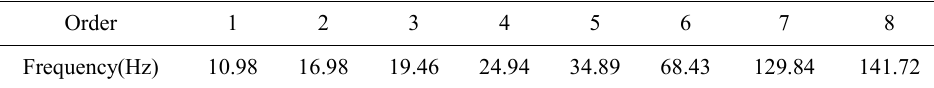
Table 2. Torsional vibration frequency of six-cylinder six-exhaust steam shafting.